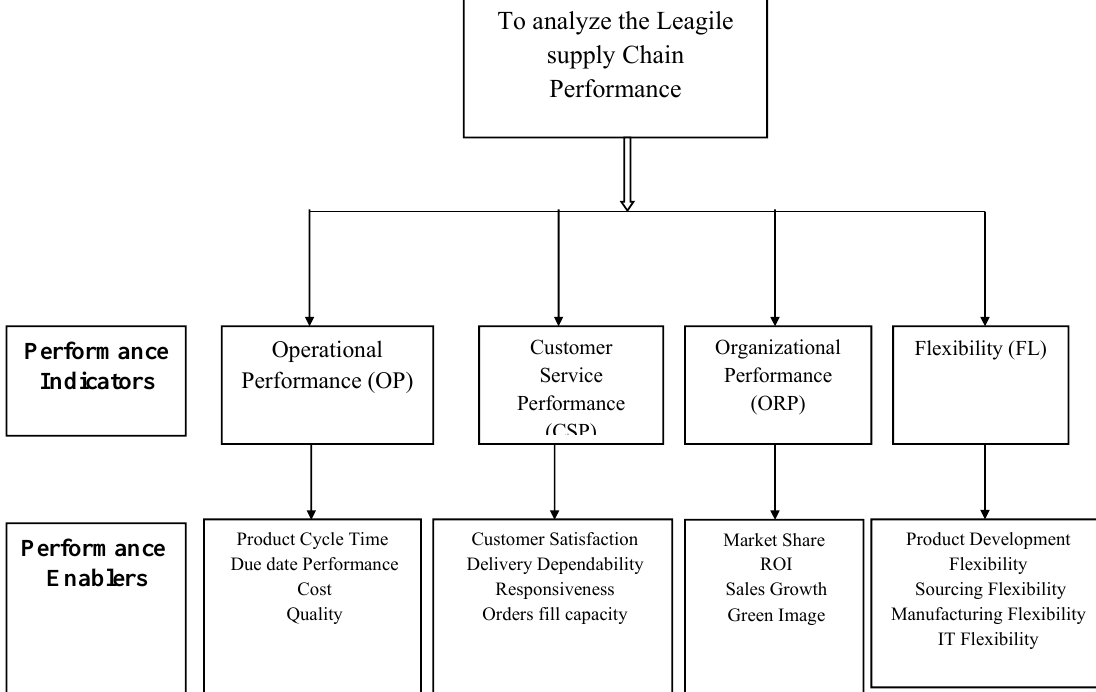
Fig. 2. Hierarchy of Performance Metrics of Leagile Supply Chain